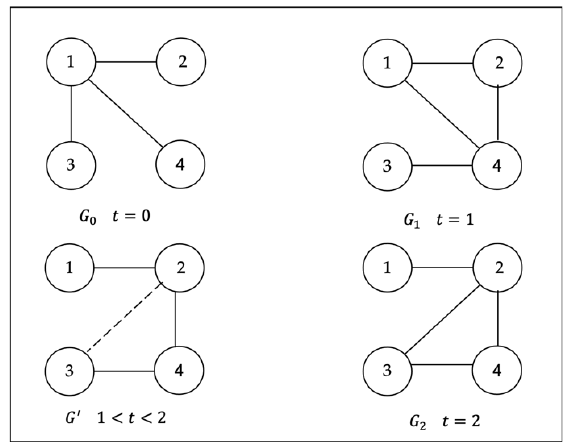
Figure 1. The snapshots of a dynamic online social network at different time stamps.